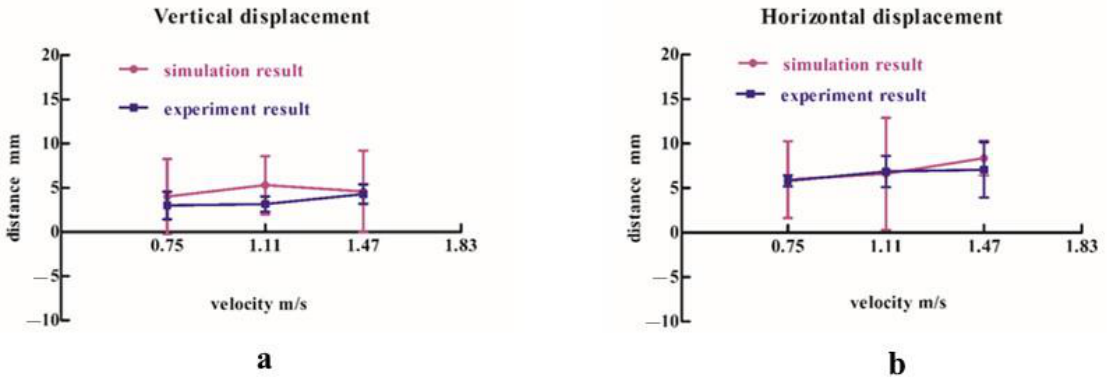
Figure 17. Comparisons of the displacements of seeds after soil compacting for the variety of forward velocities between simulations and experiments.